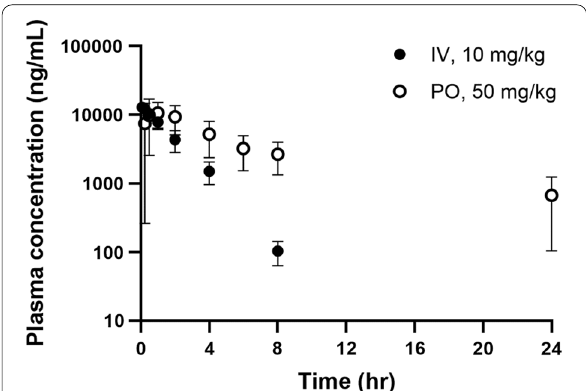
of alpelisib after intravenous (IV, 10 mg/kg; closed circles) or oral administration (PO, 50 mg/kg; open circles) in mice. Each data point represents the mean SD ( n 4 for each ± =